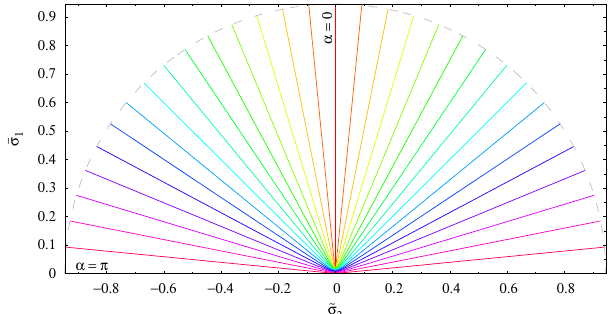
Figure 17. The same as (cid:12)gure 5 but for L = 8.